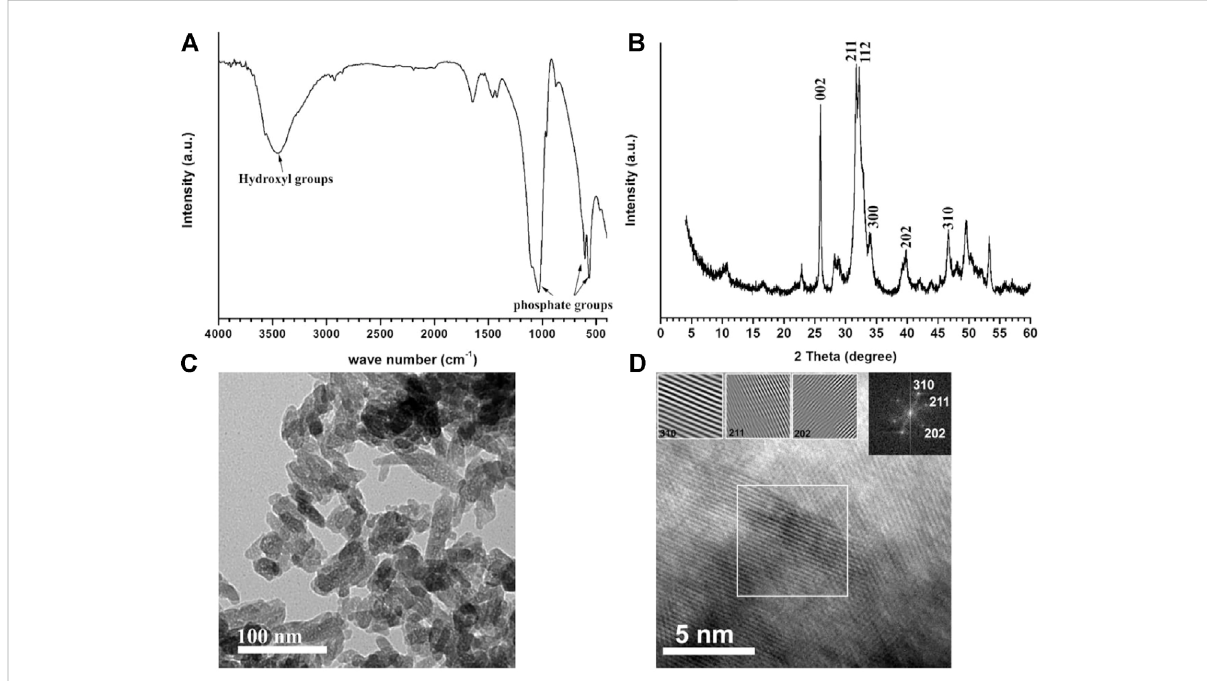
FIGURE 2 Spectroscopic analyses of Zn-doped hydroxyapatite phase, (A) FT-IR spectrum, and (B) XRD diffraction pattern. TEM micrograph (C) and HR- TEM (D) of Zn-doped hydroxyapatite. The inset image on the right-hand side in (D) represents the Fast Fourier Transform (FFT) pattern of HR-TEM, showingthreehkl-re fl ections(310,211,and202)ofHAphaseandthreeimagesofsimulatedlatticefringescalculatedfromtheareainsidethewhite- bordered square in HR-TEM